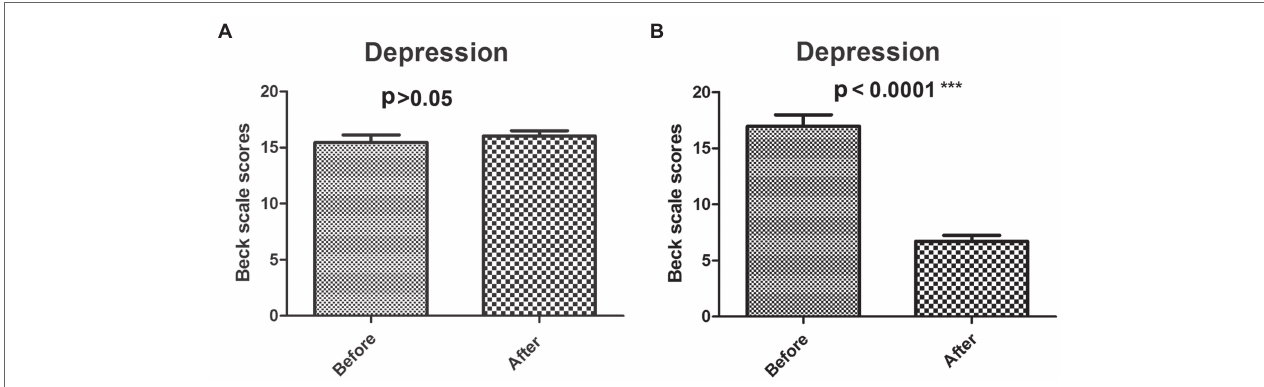
FIGURE 3 | Analysis of BDI scores before and after intervention. The dynamic BDI scores before and after GMIT intervention in control group (A) and experimental group (B) . *** p < 0.001.